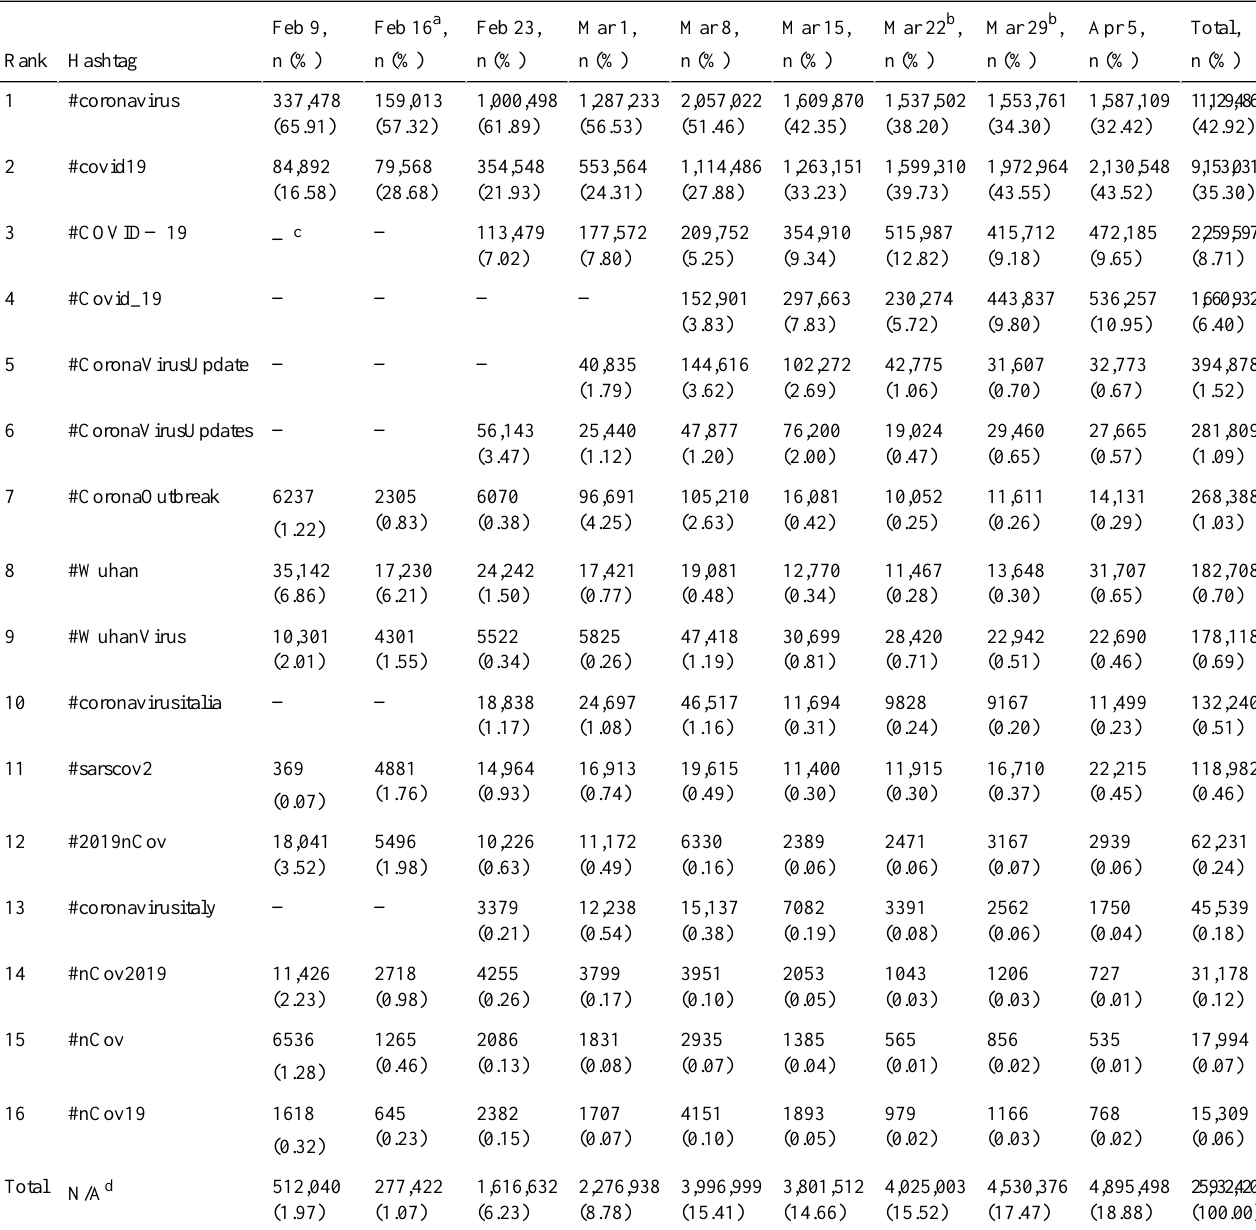
Table 2. Number of tweets per hashtag in ranked order within 7-day